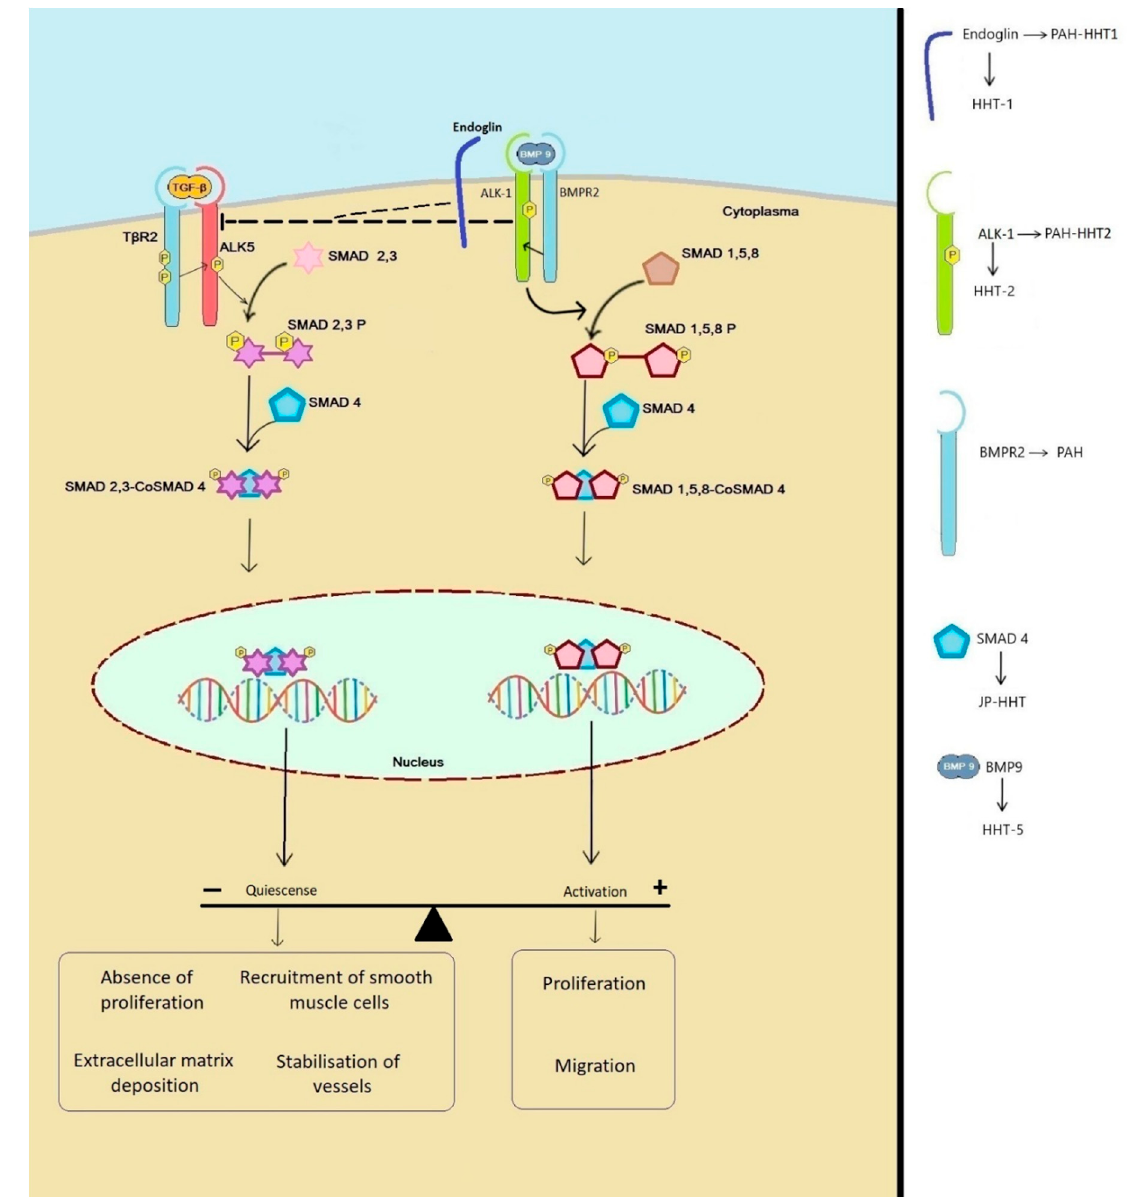
Figure 1. Molecular pathophysiology of hereditary hemorrhagic telangiectasia (HHT). Physiological signaling in endothelial cells occurs through ALK-1 and ALK-5. Signaling through ALK-1 results in the activation of the SMAD 1,5,8-CoSMAD4 pathway resulting in proliferation and migration of endothelial cells (ECs). ALK-1 (and indirectly endoglin) also inhibits ALK-5 signaling. ALK-5 signaling activates the SMAD 2,3-CoSMAD4 pathway which inhibits proliferation and migration of ECs and stimulate the stabilization of the vessels.